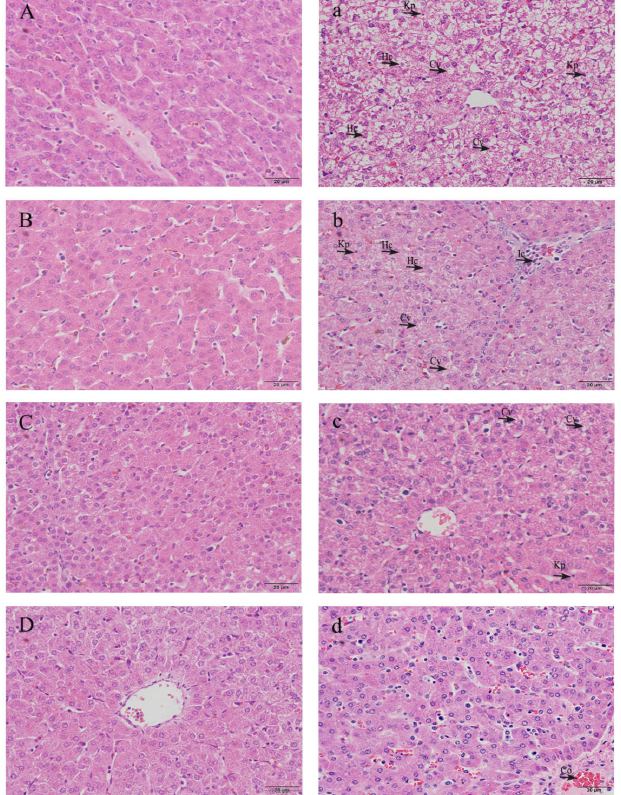
Figure 2. Effects of LPS induction on the liver microstructure of the weaned piglets. Note: Original magnification: 400 × . Scale bars = 200 µ m. (1) CON group: ( A – D ) show the liver of saline-treated weaned piglets on days 1, 5, 9, and 13, respectively; (2) LPS group: ( a – d ) show the liver of LPS-treated weaned piglets on days 1, 5, 9, and 13, respectively. Hc, hepatocyte caryolysis; Kp, karyopycnosis; Cv, cytoplasm vacuolization; Ic, inflammatory cell infiltration; Co,